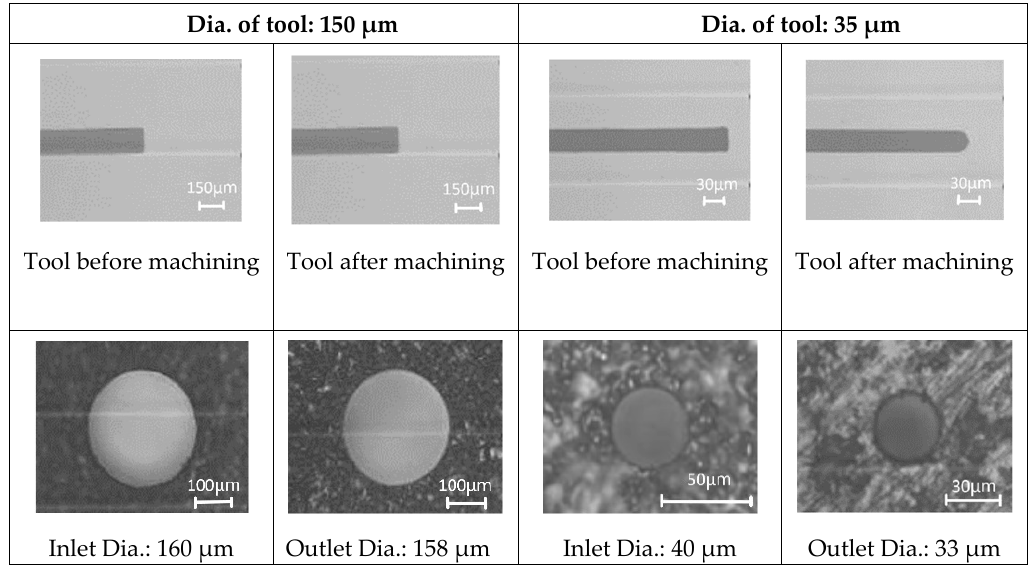
Figure 10. Micro-hole drilling on tungsten cemented carbide (WC-Co) through a desktop micro-EDM system.